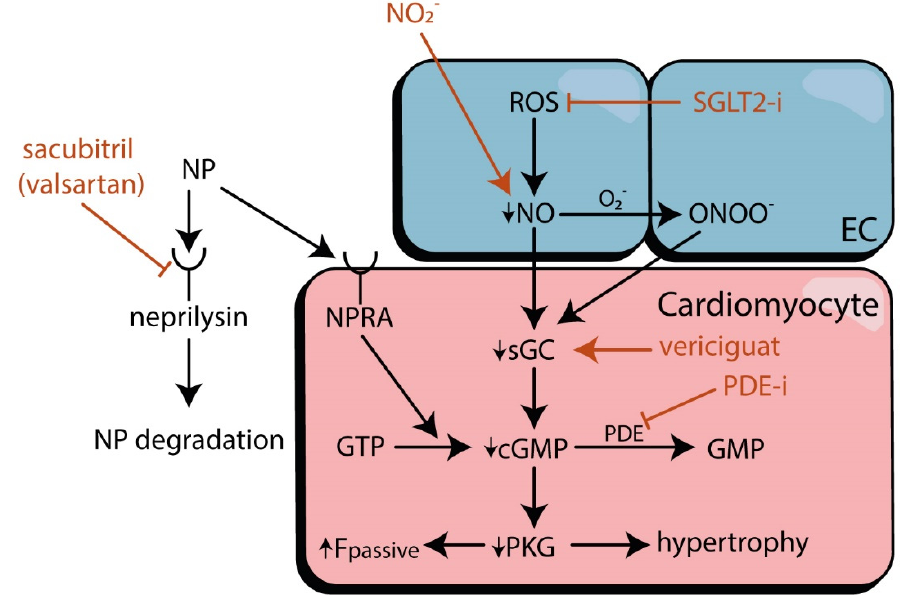
Figure 2. Interventions targeting MVD in HFpEF. The effects of different pharmacological interventions (blue) on the NO-sGC-cGMP-PKG pathway in MVD in HFpEF. ROS causes impaired NO bio-availability, subsequently disturbing the downstream signalling. The entire pathway offers different targets for therapy. cGMP, Cyclic guanosine monophosphate; EC, endothelial cell; Fpassive, passive force; NO, nitric oxide; NO 2 − , nitrite; NP, natriuretic peptides; NPRA, Natriuretic peptide Receptor Type A; O 2 − , superoxide; ONOO - , peroxynitrite; PDE-i, phosphodiesterase inhibitors; PKG, protein kinase G; ROS, reactive oxygen species; sGC, soluble guanylate cyclase; SGLT2-i, sodium-glucose co-transporter-2 inhibitor; SMC, smooth muscle cell.